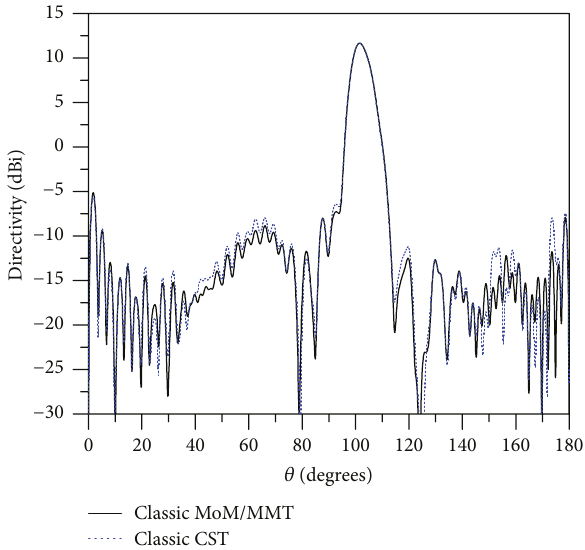
Figure 8: Generatrices and ray tracing of the classical omnidirectional ADC